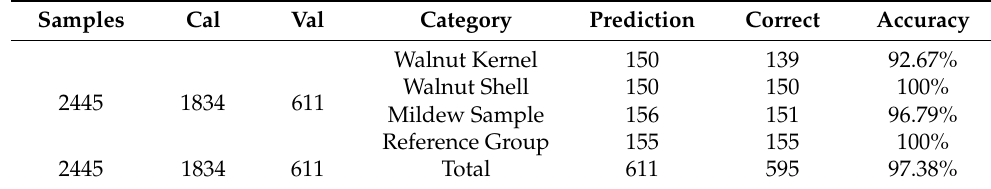
Table 2. Classification results of RF discriminant model.